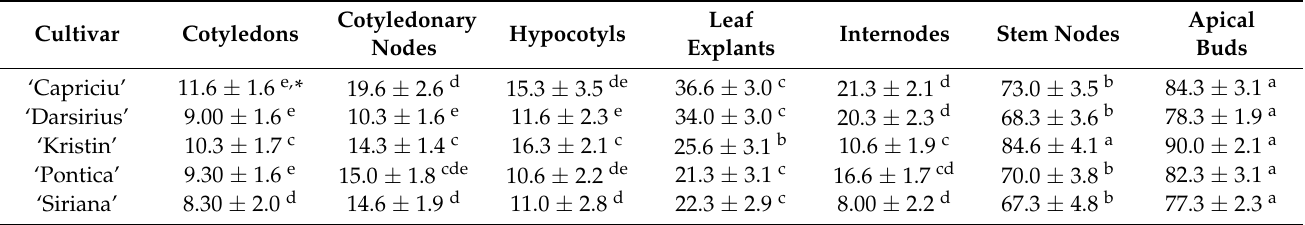
Table 2. In vitro shoot regeneration of various explants after 45 days in